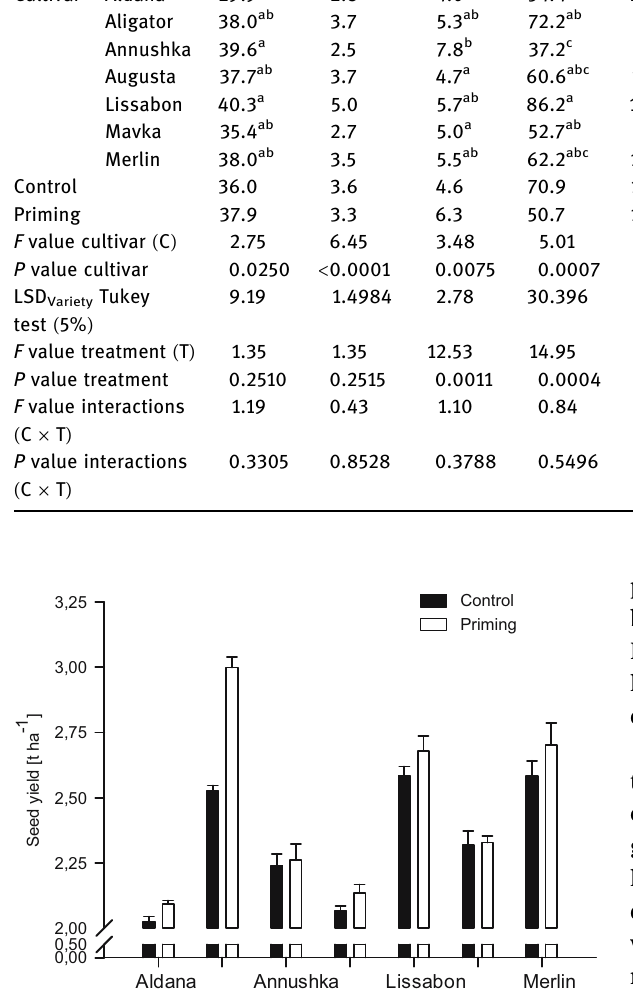
Cultivar Aldana